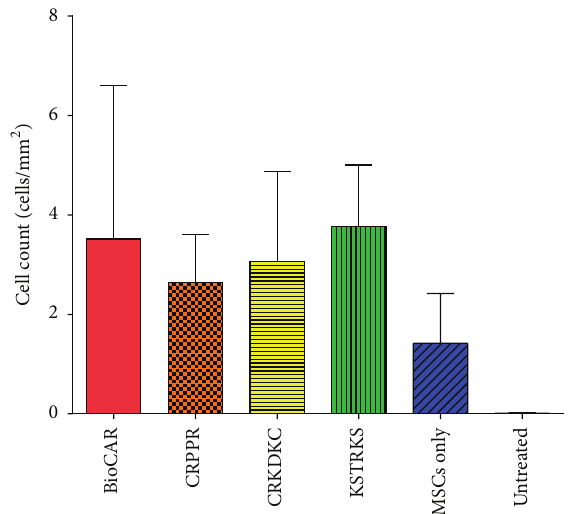
Figure 3: Cell localization in myocardial tissue. Increased cell num- bers were found in peptide-targeted (BioCAR, CRPPR, CRKDKC, and KSTRKS) MSCs than in untargeted MSCs (MSCs only). Means of 𝑛 ≥ 3 ± S . D. Total targeted versus untargeted means are 3.1 versus 1.4, 𝑃 < 0.05 one tailed Student’s 𝑡